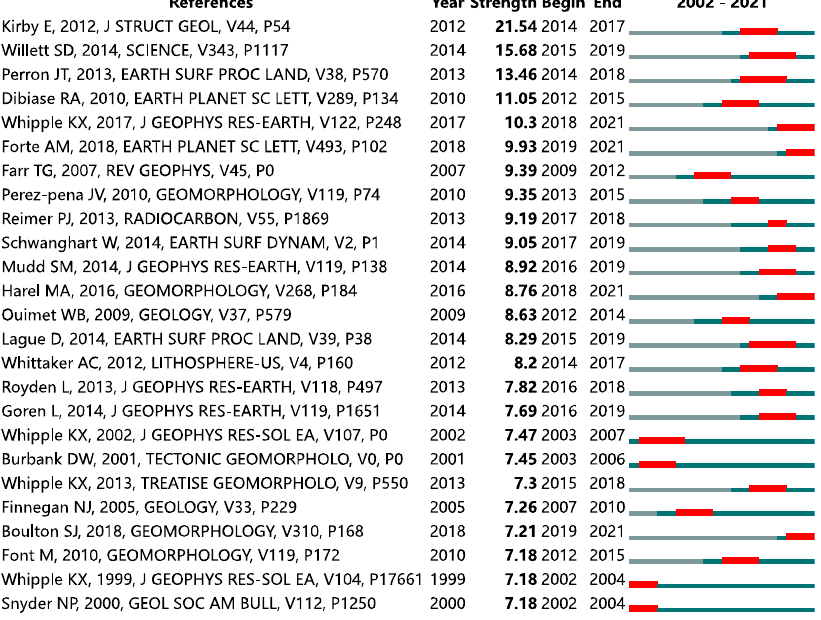
Figure 9. Top 25 references with the strongest citation in tectonic geomorphology research. Each reference is listed with the author names, year, journal name, volume, pages, and strength. The red lines are the timelines. Table 9. The nodes in the Burst analysis.